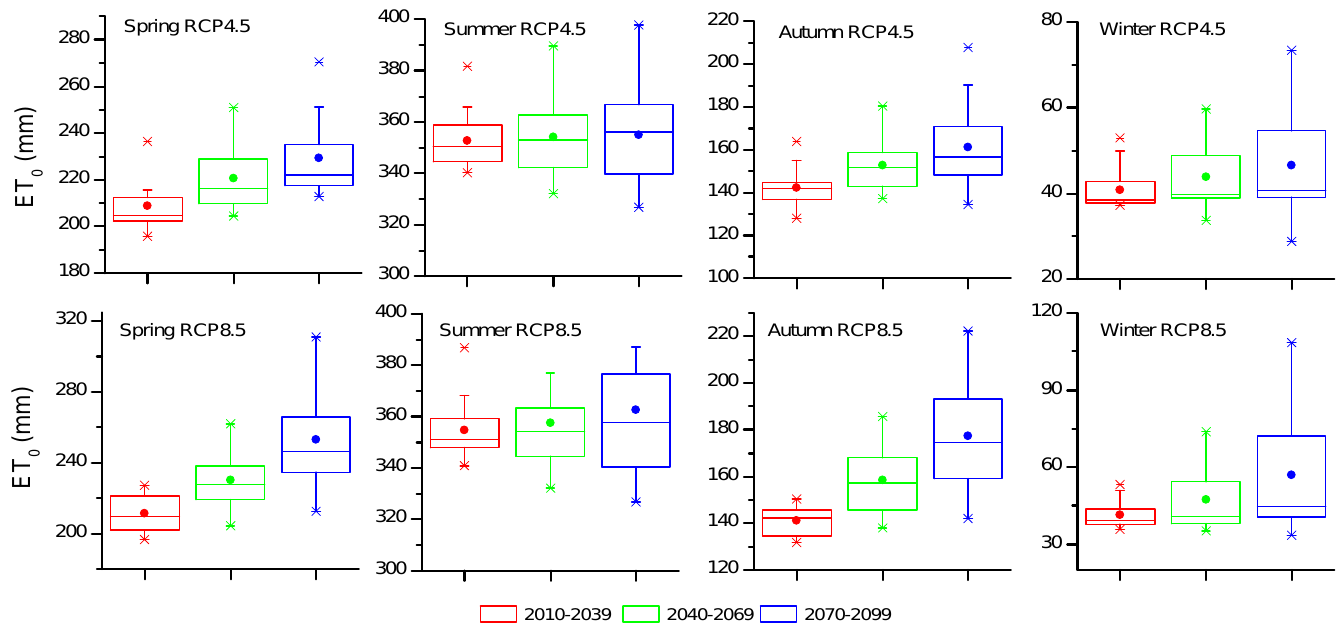
Figure 9. Boxplots for the future seasonal ET 0 projection under the RCP4.5 and RCP8.5 scenarios.